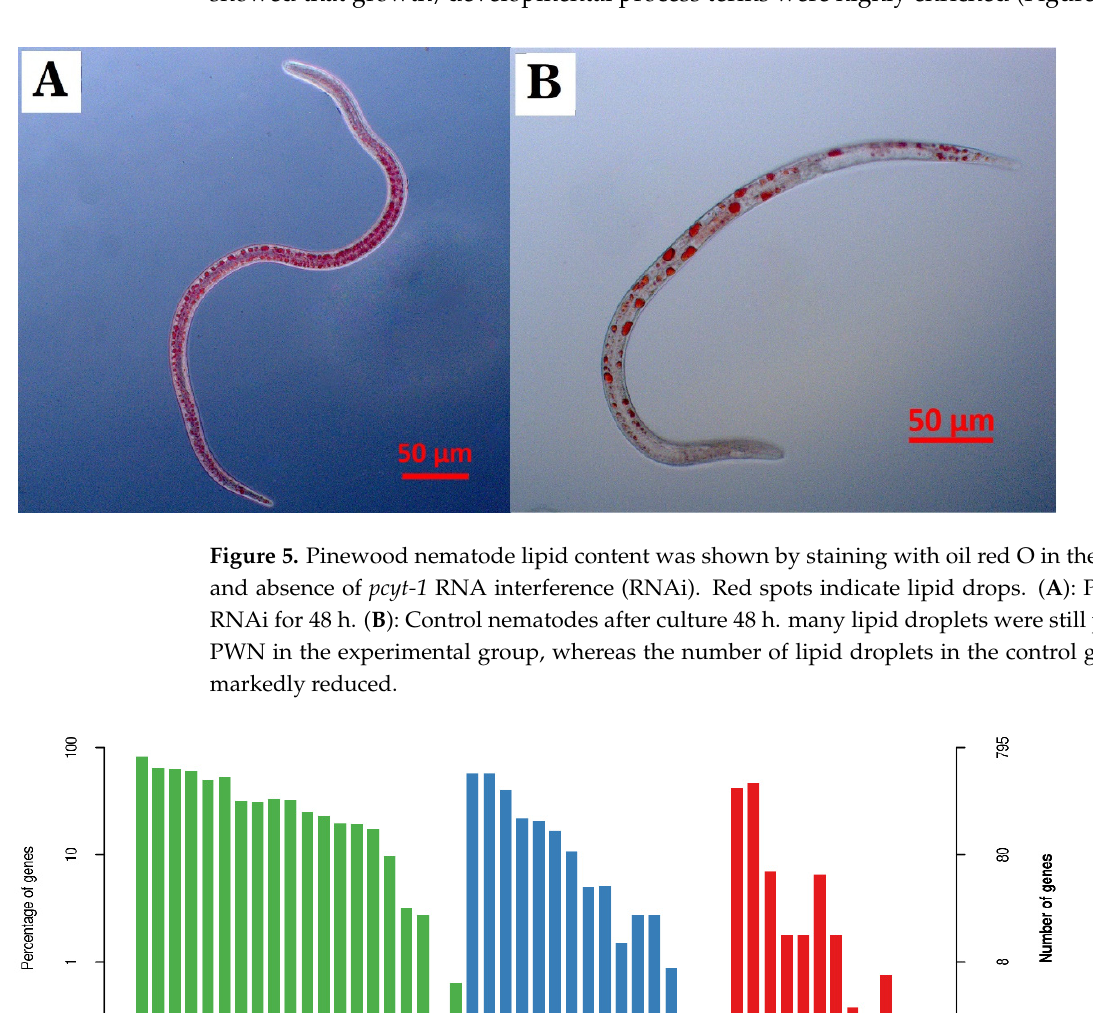
Figure 4. Relative expression of pcyt-1 in control pinewood nematodes (PWN; CK), PWN exposed to RNA interference (RNAi), and negative control (NC-RNAi).